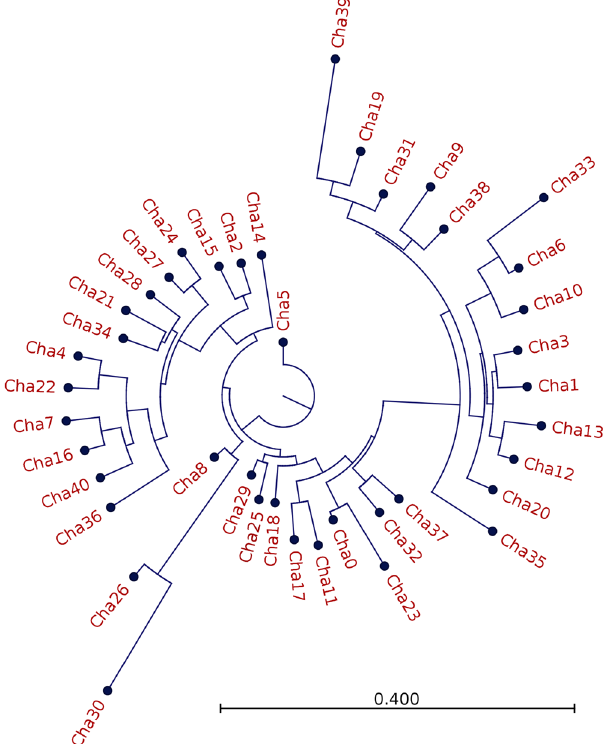
Figure 5. Circular phylogram depicting the relationships among the 41 non-redundant DAB translated peptides, inferred with Neighbour-Joining phylogenetic approach. For sequence numbering see Fig.